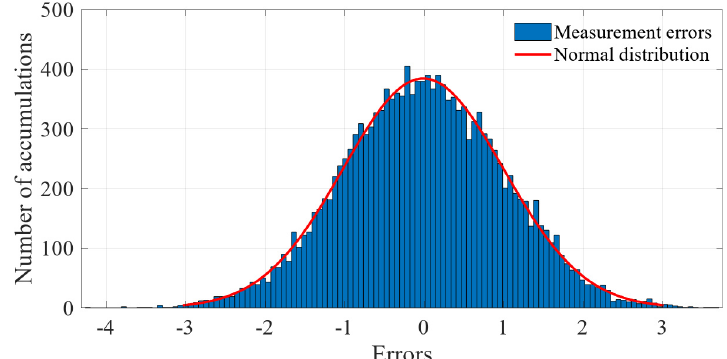
Figure 13. Measurement errors of normal data.